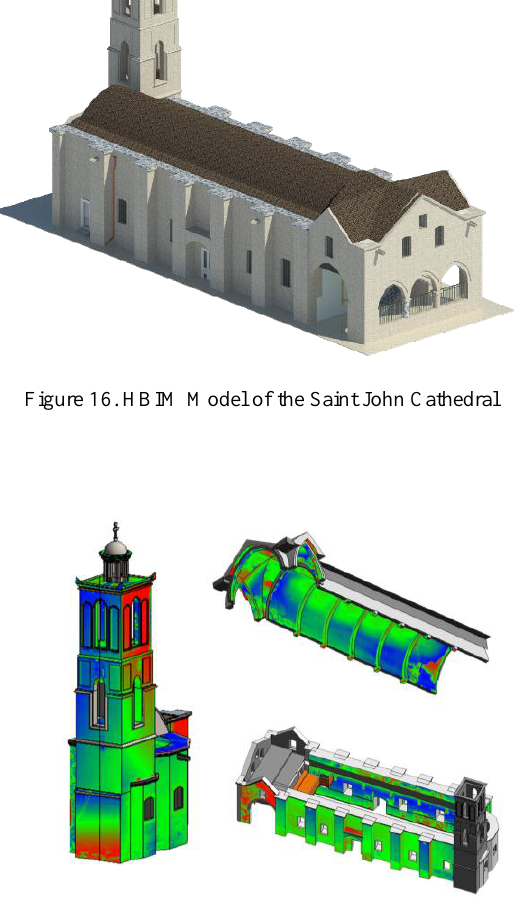
Figure 17. Analytical comparison between point cloud and HBIM Model